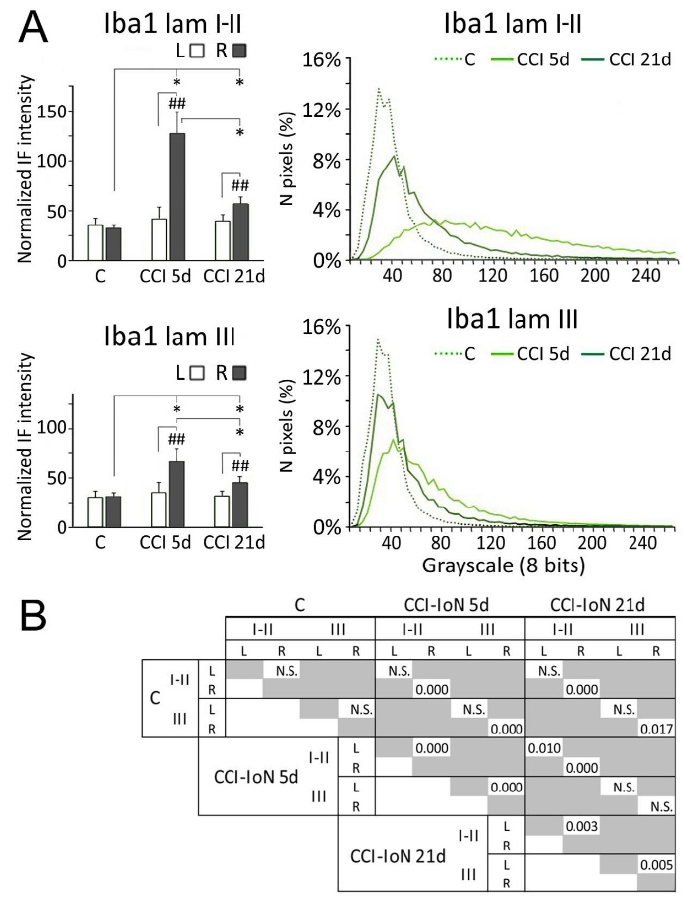
Figure 6. Comparisons of densitometric measurements for Iba-1 ( A ) in laminae I-II ( top panels ) and III ( bottom panels ). In histograms, * indicate statistical significance ( p < 0.05) between groups, using hemispheres as sampling units (Mann-Whitney test, n = 4 in C and n = 6 in CCI-IoN cases). Differences between sides in each group were assessed by the Wilcoxon signed rank test using individual sections por pairwise comparisons ( n = 12 in C and n = 18 in CCI-IoN cases; ## = p < 0.01). For statistical comparisons of pixel distributions, see Figure 4.The statistical comparisons (Kolmogorov-Smirnov D test) of densitometric curves are shown in ( B ).